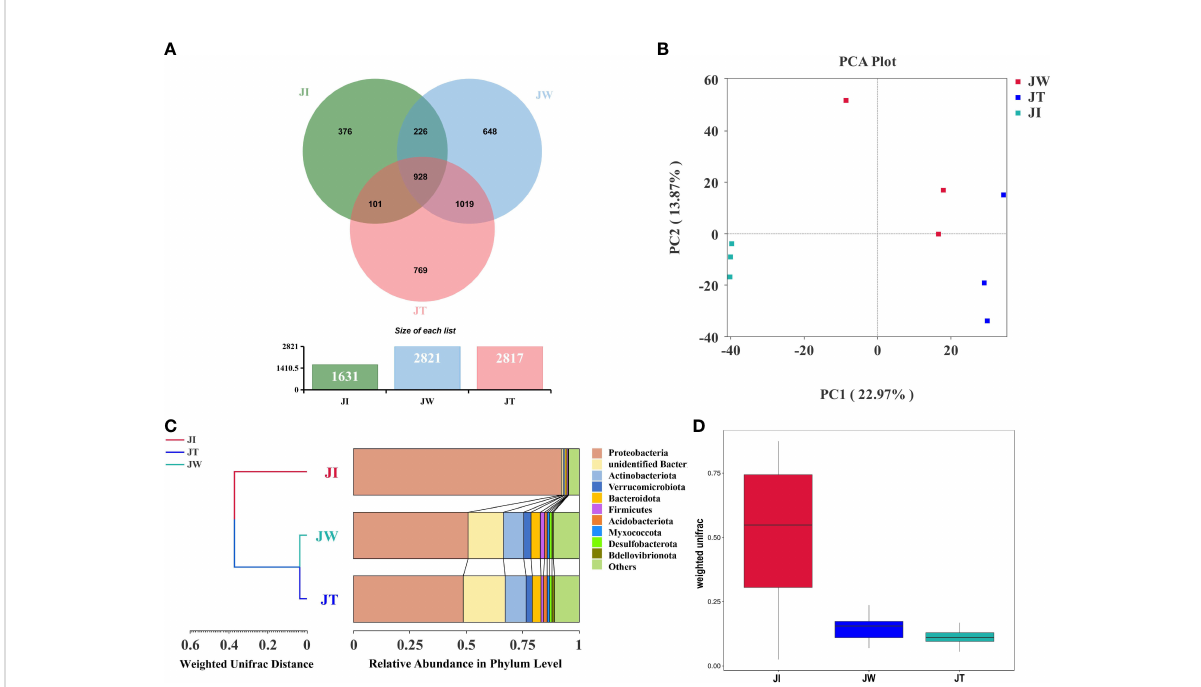
FIGURE 5 Associations between microbial communities of shrimp intestinal, water, and ef fl uent samples in “ Fishery-PV Integration ” ponds. (A) Venn diagram of unique and shared bacterial OTUs from intestinal contents (JI), water (JW), and ef fl uent (JT). (B) PCA distribution plot; samples from the same group are clustered closer. (C) UPGMA clustering tree based on the Weighted UniFrac distance at the phylum level. The length of the branches represents the distance between the samples. If the composition of the microbial communities in the samples is similar, they will be clustered together in the clustering tree. (D) Weighted UniFrac analysis of intestinal contents (JI), water (JW), and ef fl uent